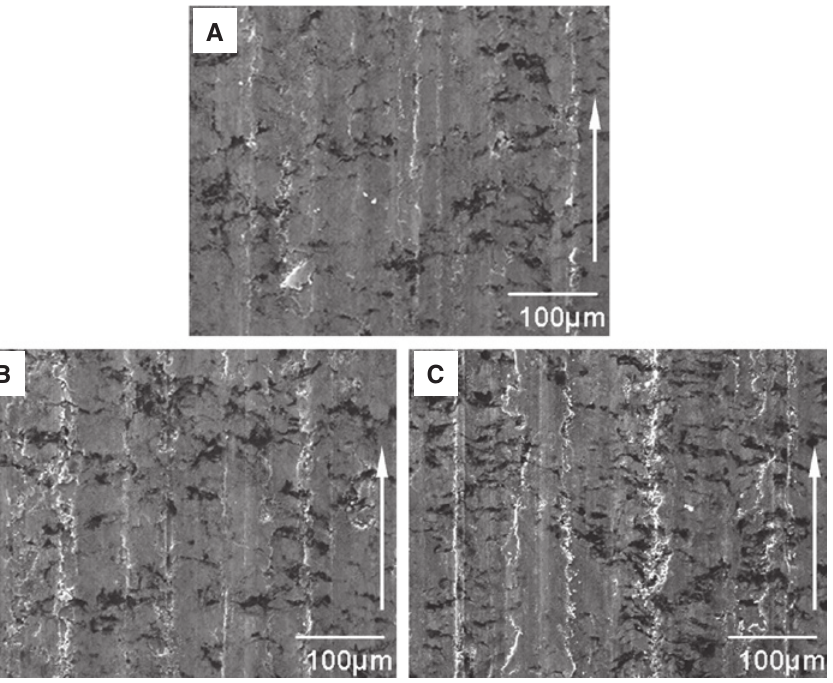
-graphite-multi-wall WS nanotubes (Cu-WS -G- 2 2 2